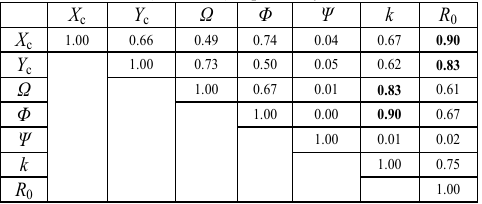
Table 6. Mean correlation matrix of octagonal cone model fitting with the real data (Pole 1 - 3) captured by the Faro Focus 3D